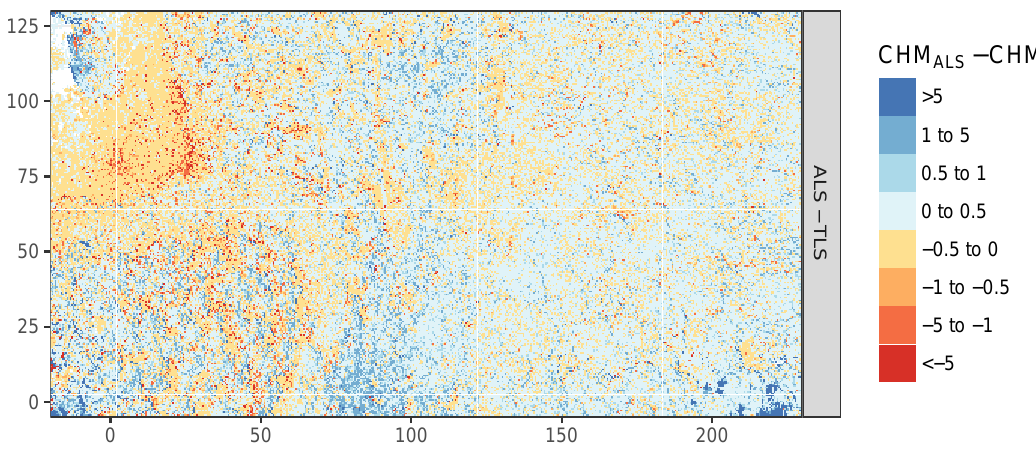
Figure 6. Differences in Canopy Height Models (CHMs). Colour height bins were chosen according to histogram and to facilitate evaluation of the sign of the difference.